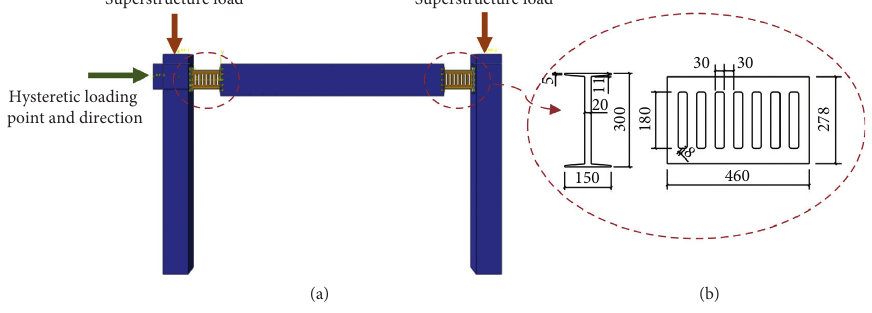
Figure 2: Frame model